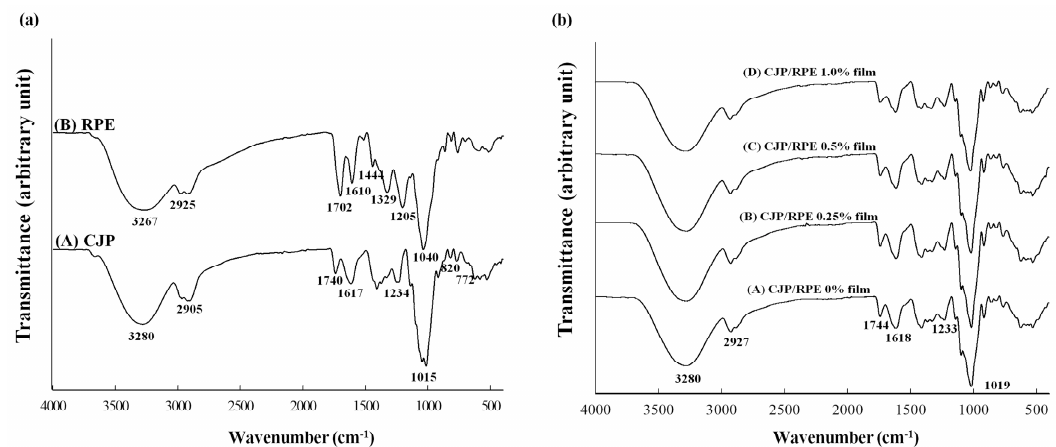
Figure 2. FTIR of the CJP films containing different concentrations of RPE.